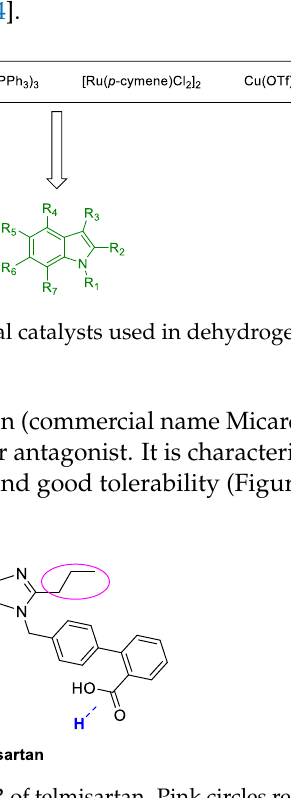
Figure 6. (Q)SAR of telmisartan. Pink circles represent lipophilic pockets; blue dashed lines represent H-bond donor sites [76].